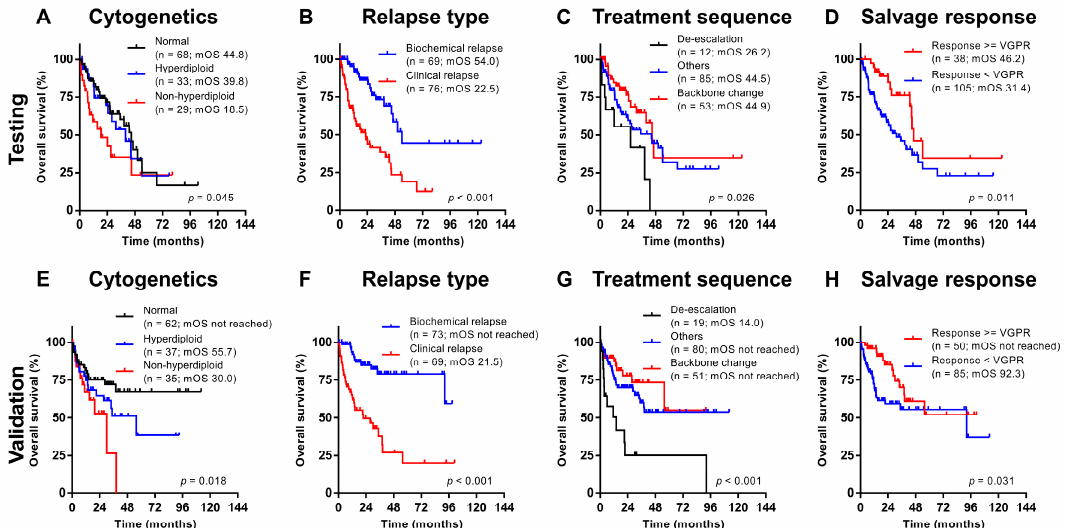
Figure 2. Progression free survival categorized according to different prognostic factors in the testing (( A ) cytogenetics; ( B ) relapse type; ( C ) treatment sequence; ( D ) salvage response) and validation (( E ) cytogenetics; ( F ) relapse type; ( G ) treatment sequence; ( H ) salvage response) cohorts.